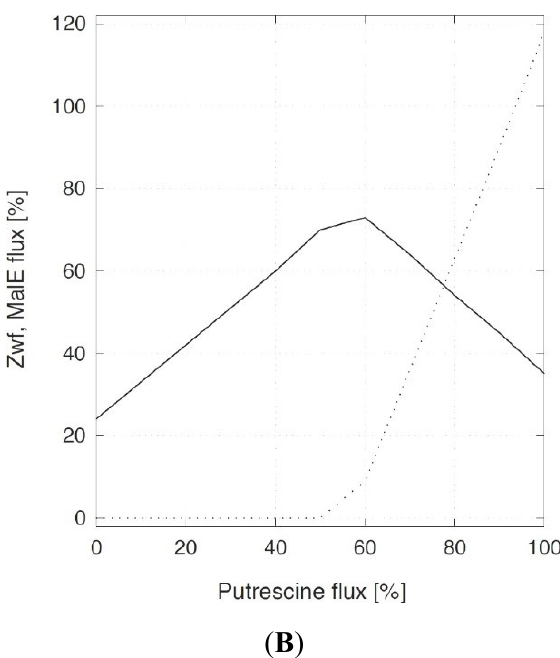
Figure 1. Metabolic flux distribution in C. glutamicum ( A ) and the relative flux through glucose 6-phosphate dehydrogenase Zwf and malate enzyme (MalE) ( B ) as a function of putrescine production. ( A ) Objective function was biomass flux, except for 100% putrescine flux. The metabolic flux was distributions were calculated in C. glutamicum without (in black) and with (in red) putrescine secretion to obtain yield coefficient (Y P/S ) of 25, 50, 75, 94%, respectively, relative to the glucose uptake rate. All fluxes are given in percent and are normalized to glucose uptake. Values are sorted by increasing putrescine flux. Solid line: Zwf flux, dotted line: MalE flux. For abbreviations: 1,3PG: 1,3-Bisphosphogylceric acid, 2OXO: 2-Oxoglutaric acid , 2PG: 2-Phosphoglyceric acid, 3PG: 3-Phosphoglyceric Dihydroxyacetonephosphate, F6P: Fructose-6-phosphate, G6P: Glucose-6-phosphate, GA3P: Glyceraldyehyde-3-phosphate, GLC: Glucose, GLC-LAC: 6-Phosphogluconolactone, GLC6P: 6-Phosphogluconic acid, GLU: L -Glutamic acid, GLY: Glycerol, GLY3P: Glycerol-3- phosphate, ICI: Isocitric acid, L -RIB5P: L -Ribulose-5-phosphate, MAL: Malic acid, NAC-GLU: N-Acteylglutamic acid, OAA: Oxalacetic acid, ORN: L -Ornithine, PEP: Phosphoenolpyruvic acid, PUT: Putrescine, PYR: Pyruvic acid, RIB: LRibulose, RIB5P: Ribulose-5-phosphate, RIBO5P: Ribose-5-phosphate, S7P: Sedoheptulose-7-phosphate, E4P: Erythrose-4-phosphate, SUC: Succinic acid. Arrows from intermediates marked in grey boxes perpendicular to the metabolic reactions indicate flux into